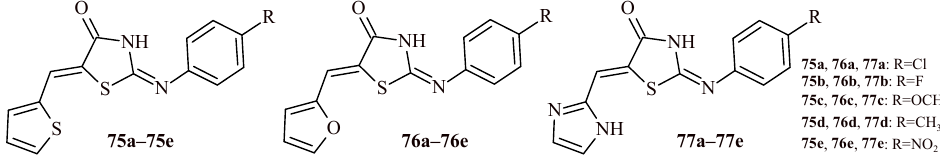
colorimetric kit. Suramin was used as a standard. The inhibitory potency was investigated by measuring the effect of each compound on phosphate production, the results of the inhi- bition assay are expressed as IC 50 . Generally, the resulting derivatives showed moderate to good inhibition of PTP1B. Their IC 50 values ranged from 5.88 µ M ( 76e ) to 29.78 µ M ( 77a ). For comparison, the result of suramin (the reference substance) was 10.98 µ M. was 10.98 µM.